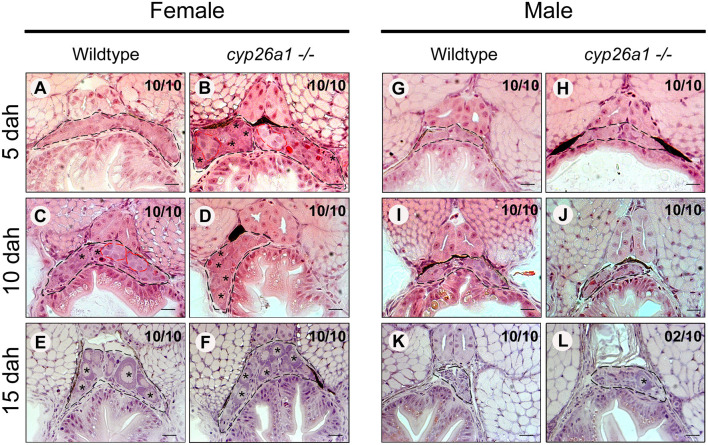
Germ cell proliferation and differentiation during male and female gonad development in wildtype and cyp26a1–/–medaka. Gonad (black dashed lines) of cyp26a1–/–female present higher amounts of differentiated germ cells (red dashed lines) at 5 days after hatching (dah) in comparison with the wildtype (A,B). At 10 dah, differentiated germ cells are more preeminent in the wildtype female, while in the mutant, the higher amount of pre-vitellogenic oocytes (star) indicates more advanced stage of oogenesis (C,D). At 15 dah, no apparent differences were observed in female gonads (E,F). In males, no differences were observed between wildtype and mutant at 5 dah (G,H) and 10 dah (I,J). At 15 dah, no sign of germ cells differentiation is observed, by comparing with the wildtype gonad (K,L). However, some cyp26–/–males presented pre-vitellogenic oocytes (star). Scale bar = 20 μm.